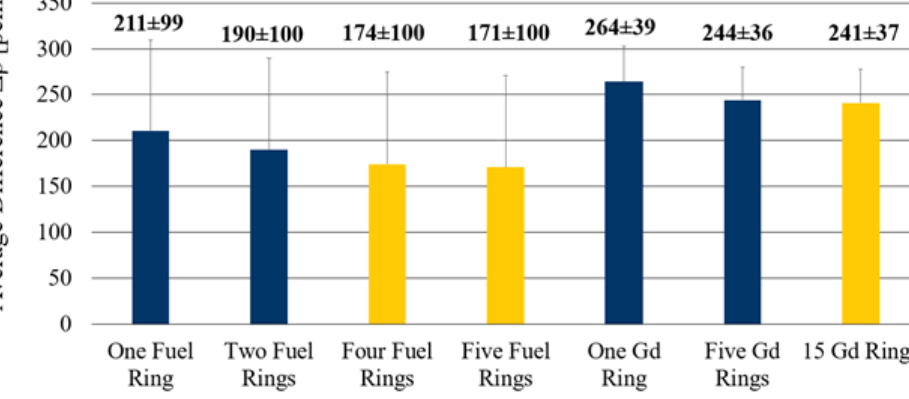
Figure 17. Average difference from MPACT default k inf for 2-D assembly spatial mesh